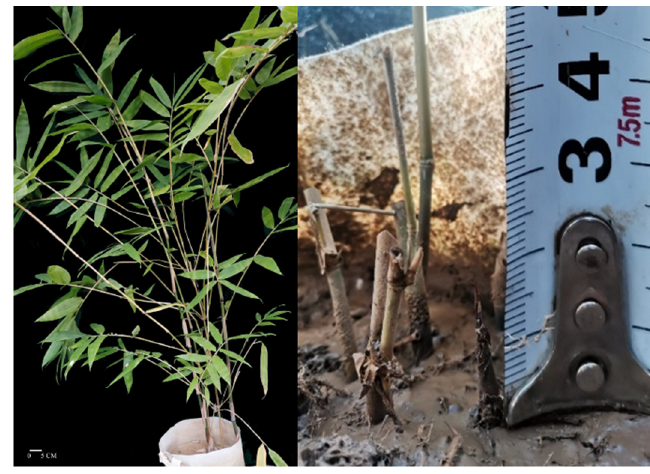
Figure A2. The germination of bamboo shoots of Ma bamboo. Table A1. Variation of average light intensity under different management types of Ma bamboo. Note: Data in the same column with different letters denote a significant difference ( p <